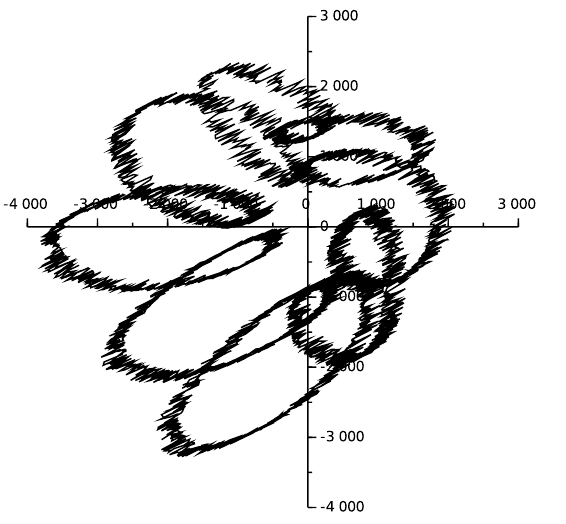
Figure 12. Bode plot of the transfer function for the liquids listed in Table 1.